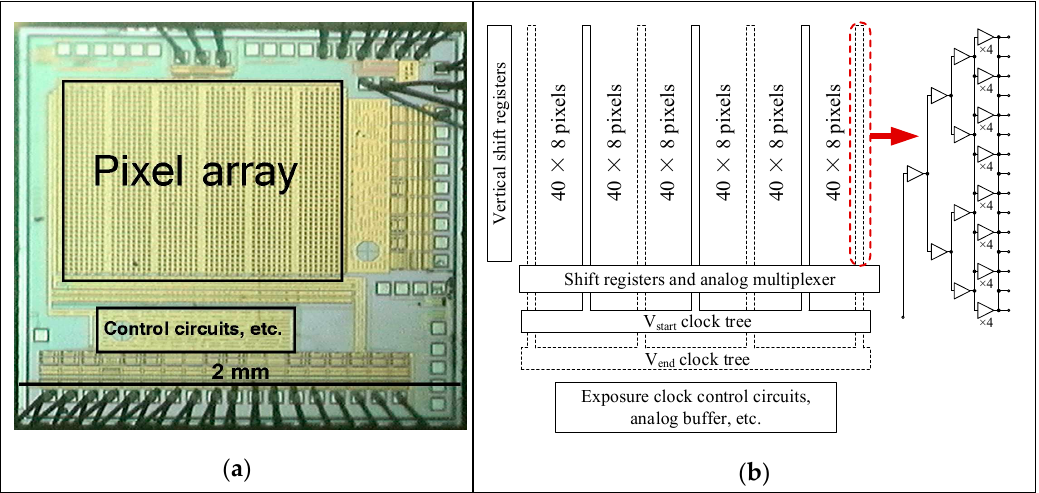
Figure 4. Simplified circuit model of a pixel. ( a ) Before exposure. ( b ) During exposure.